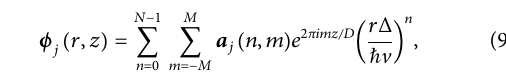
FIGURE 4 Energy spectrum labeled by the quantum number | j | of two rough nanowires of (A) R = 2.5 Z v / Δ and (B) R = 5.5 Z v / Δ and roughness parameters δ R = Z v / Δ and D = 5 Z v / Δ . For comparison energy spectra for the corresponding uniform nanowire is presented in every panel with dashed